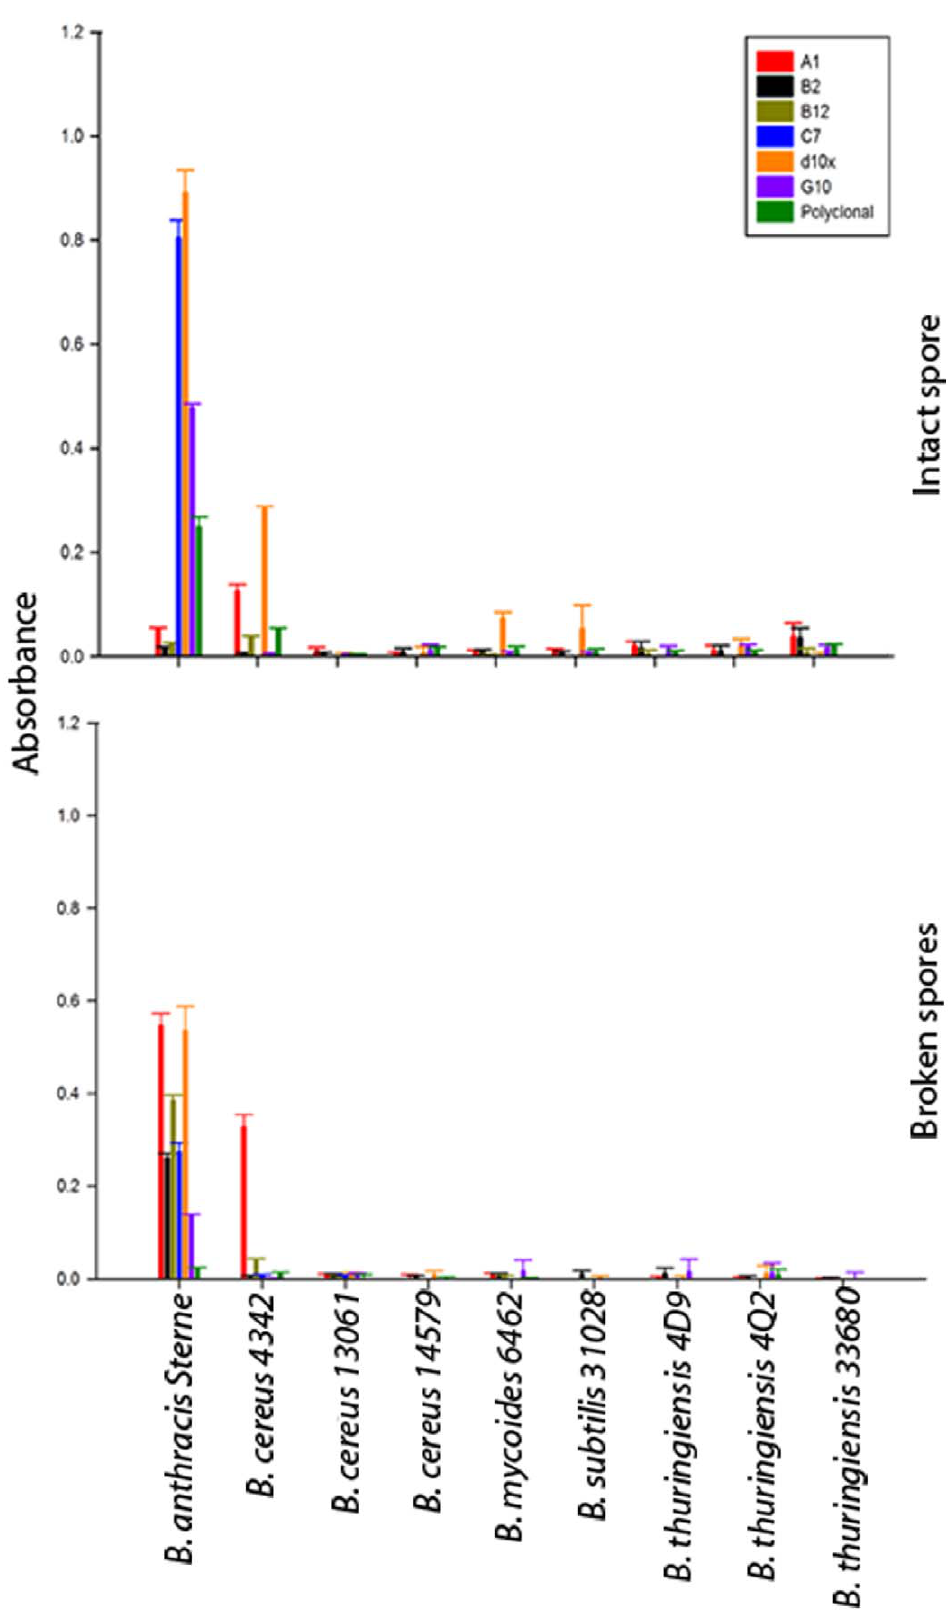
Figure 4. Specificity of sdAbs for Bacillus species spores. Intact and broken spores were passively immobilized to microtiter plates at equivalent optical densities to assess specificity of sdAbs. doi:10.1371/journal.pone.0032801.g004 PLoS ONE |